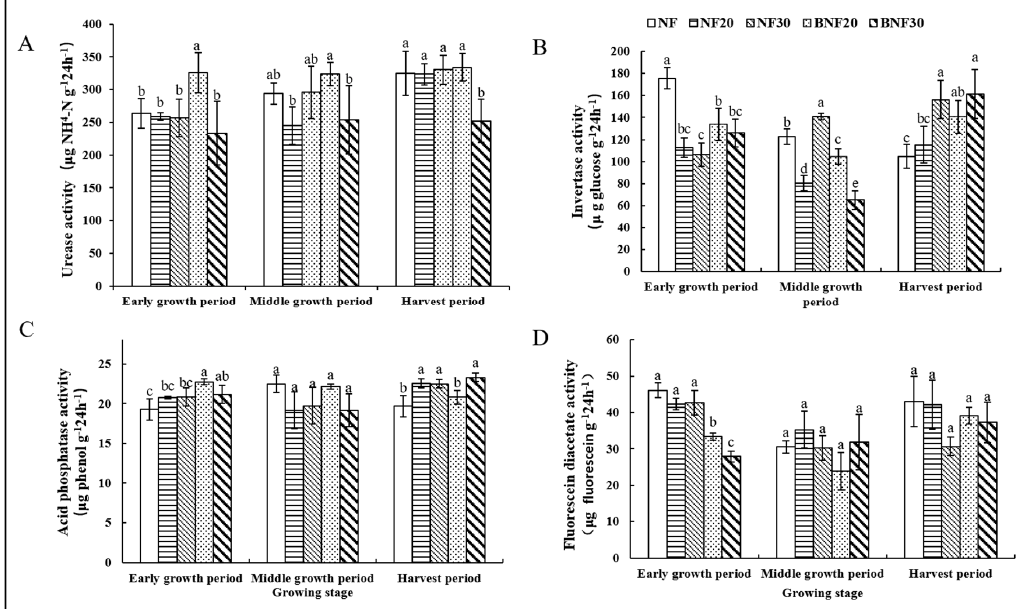
Figure 1. Soil-enzyme activities at the root soil of ‘yellow rose’ cabbage under different fertilization treatments; ( A ) urease activity; ( B ) invertase activity; ( C ) acid phosphatase activity; and ( D ) fluorescein diacetate activity. Note: At the same period, the results are the average of three different plant external green leaves; the same below.